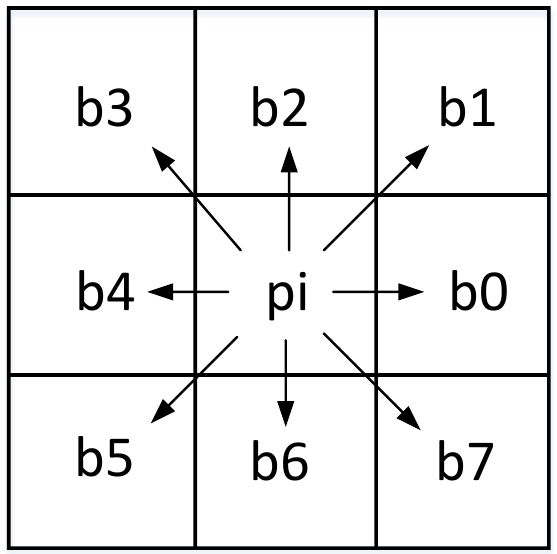
Figure 7. Eight-directional pointing value Freeman’s chain code. Figure 7. Eight- directional pointing value Freeman’s chain code.